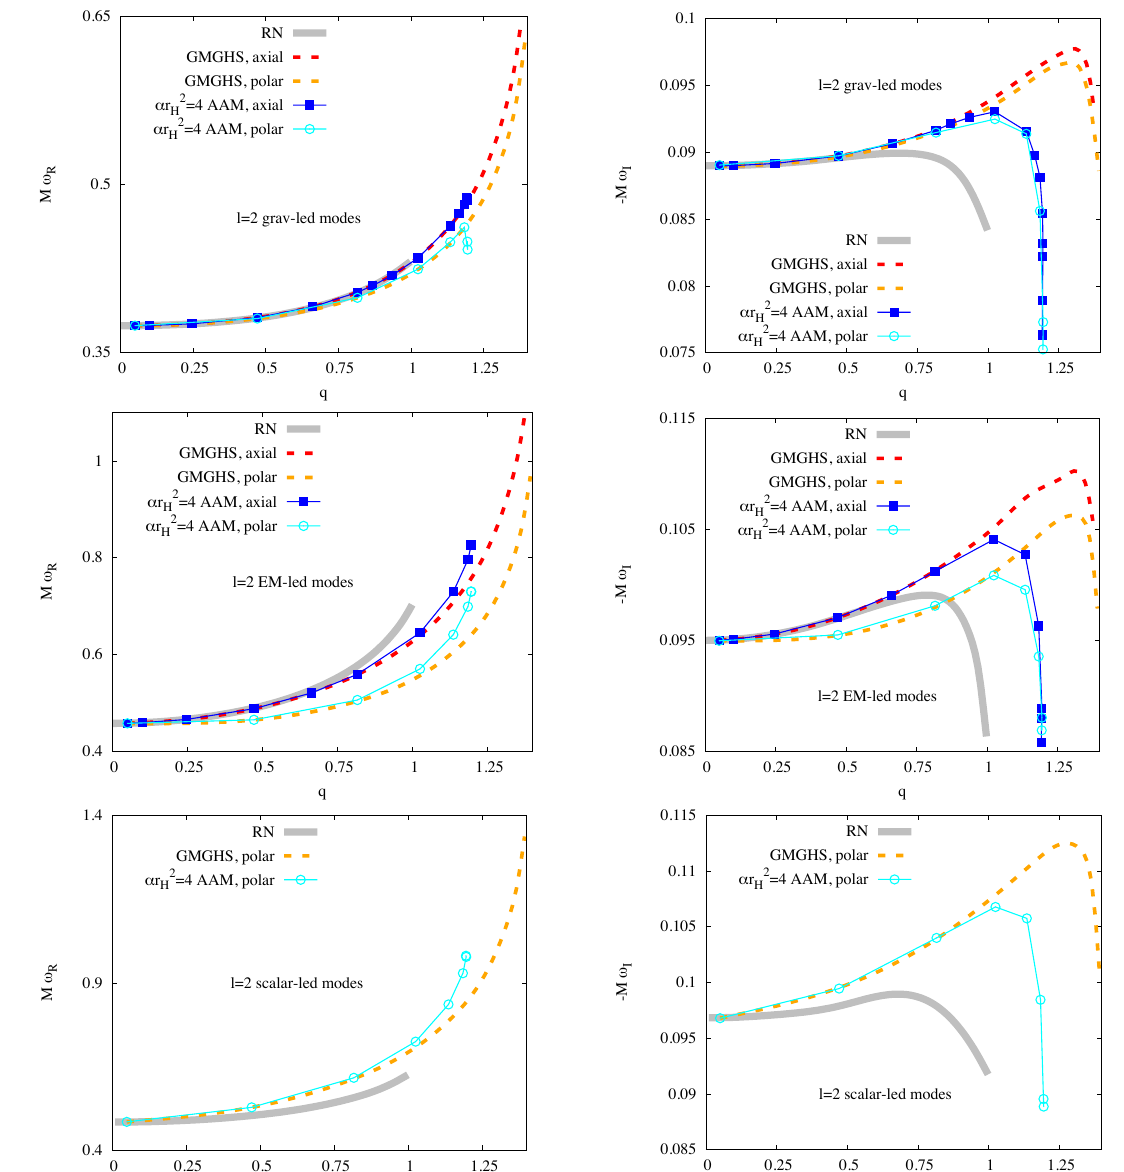
Figure 4 . Real (imaginary) part of ! for l = 2 perturbations as a function of q are shown in the left (right) panels. In the top we show grav-led modes (axial and polar), in the middle EM-led modes (axial and polar), and in the bottom scalar-led modes (polar). We show results for RN (with a continuous grey line), GMGHS (with dashed red/orange line for axial/polar modes) and the AAM BHs with (cid:11)r 2 = 4 (with dotted blue/cyan curves for axial/polar modes). H